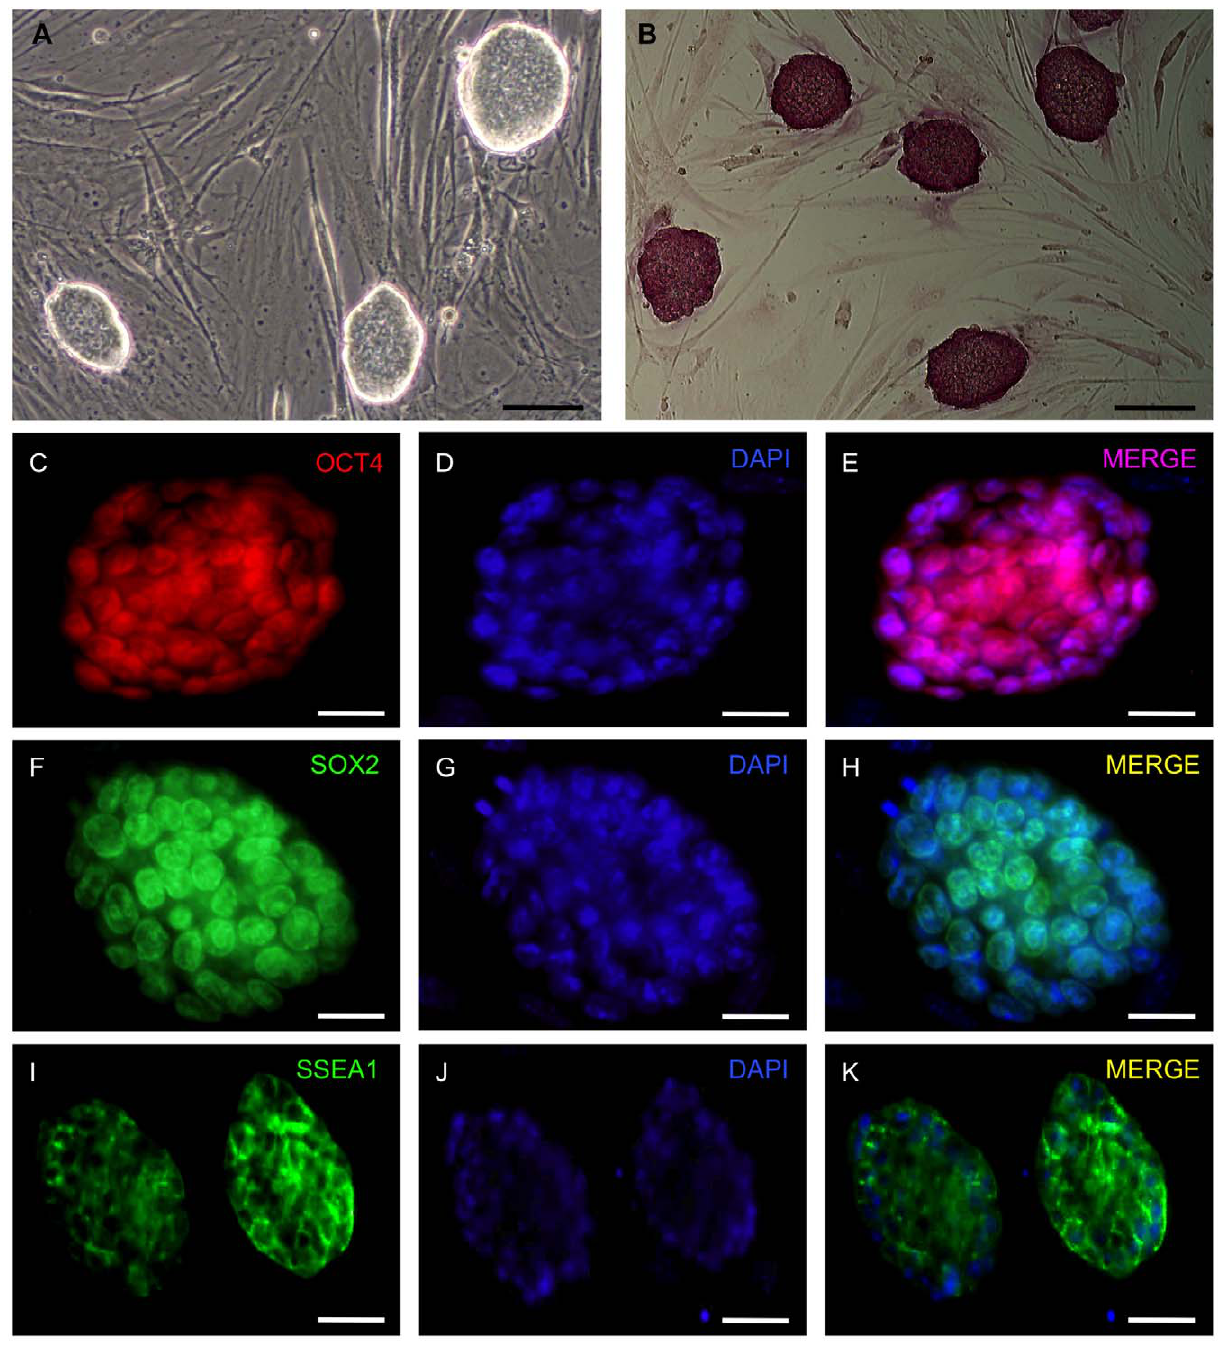
Figure 1. Characterization of iPS cells from FAH 2 / 2 mice. (A) Morphology of FAH 2 / 2 -iPS cells (line # 7) grown on MEF cells under murine embryonic stem cell culture conditions. (B) Alkaline phosphatase activity demonstrates homogenous staining in FAH 2 / 2 -iPS cell colonies. (C–K) Immunofluorescence analyses for Oct4, Sox2, and SSEA1 confirms the induction of pluripotency in FAH 2 / 2 -iPS cells. Scale bars, 100 m m in (A) and (B) and 50 m m in